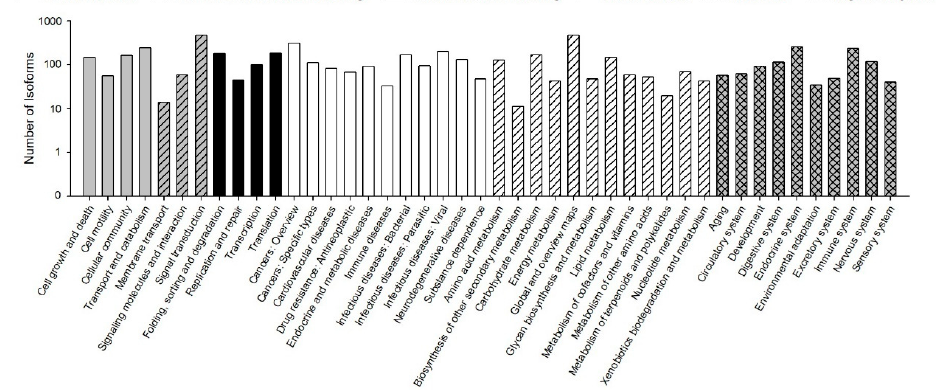
Figure 5. Functional distribution of Kyoto Encyclopedia of Genes and Genomes (KEGG) annotation. The x-axis represents the KEGG function category. The y-axis represents the number of isoforms.